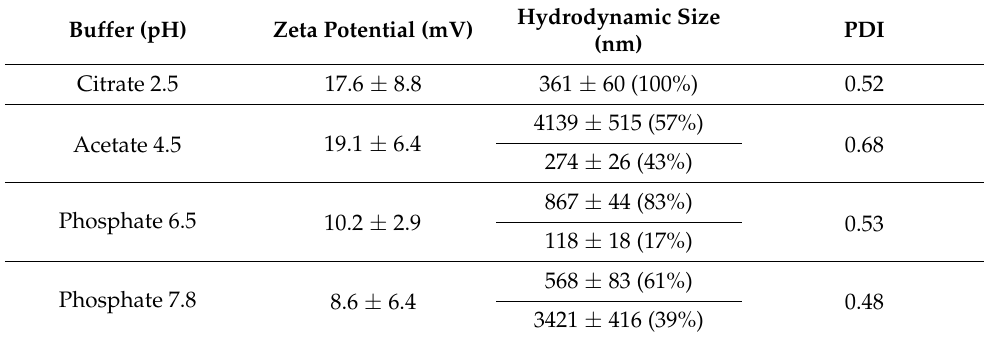
Table 2. Bioparticle structural characteristics in different buffer solutions, all at 8 mM.